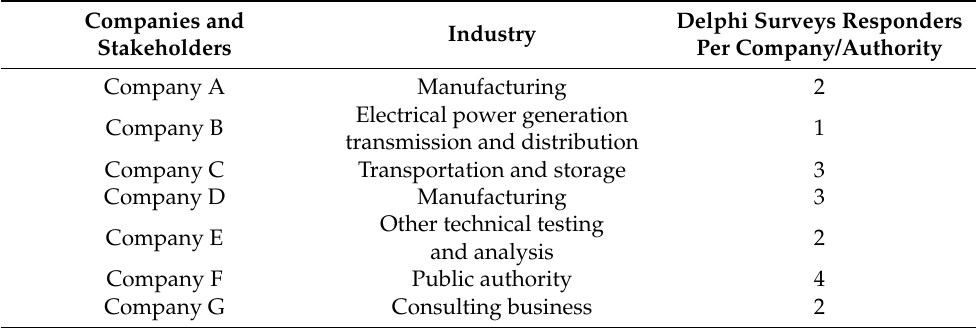
Table 1. Background information of the Delphi survey ( n =